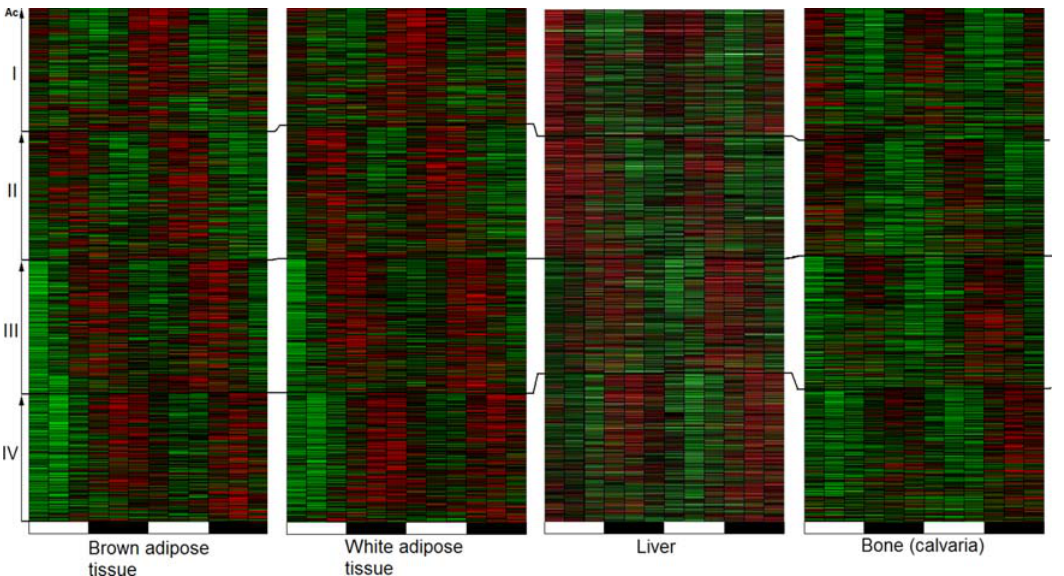
Figure 1. Circadian expression pattern in transcripts never called present. In spite of being considered silent most genes called absent are expressed in a daily changing pattern of elevated (red) and lowered expression level (green) over the 48h period of alternating light and darkness (bottom), consistent with circadian pattern in highly expressed genes. The plot shows four phase groups (roman numbers) in four murine tissues (data from [10] and [12]). On each pane expression profiles are stacked in order of autocorrelation with 24h lag (Ac, vertical axis).